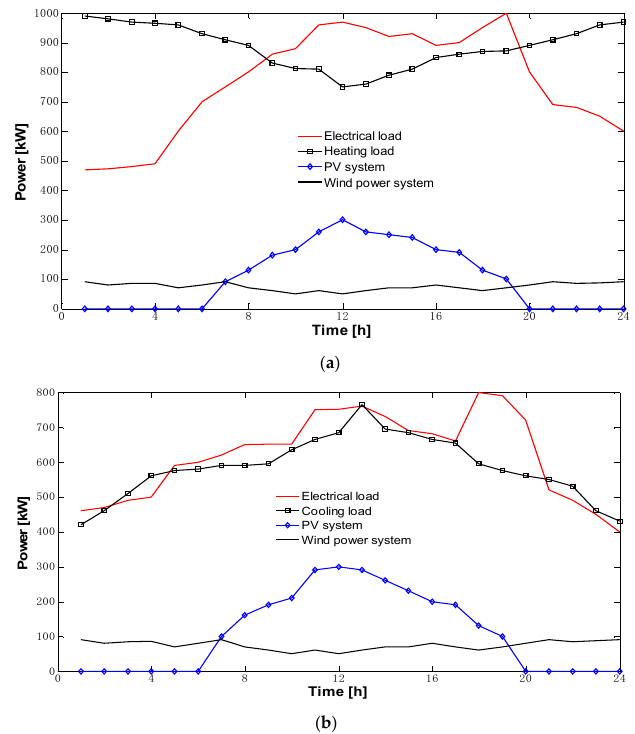
Figure 6. The day-ahead predictive data of the wind and PV power generation system, and the cooling-heating-electricity load in: winter ( a ); and summer ( b ).